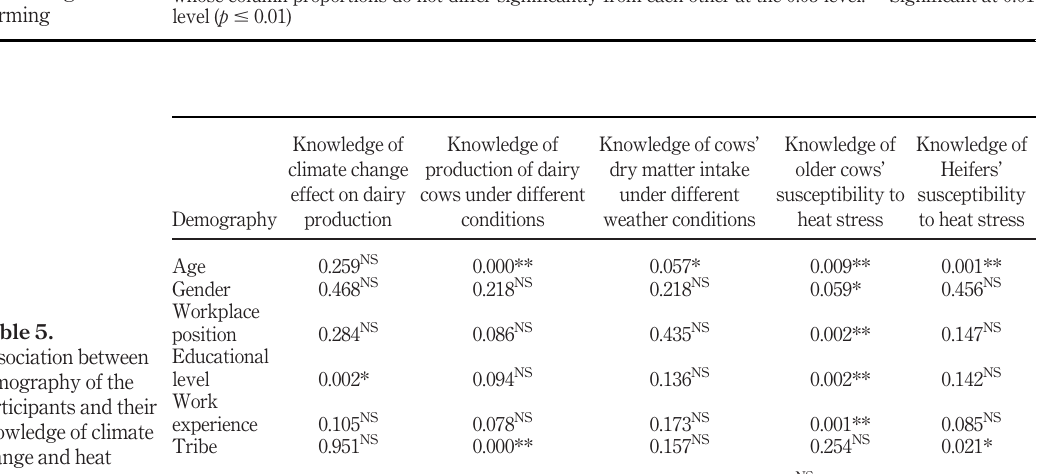
Table 4. Associations between demography and knowledge of climate change relation to global warming